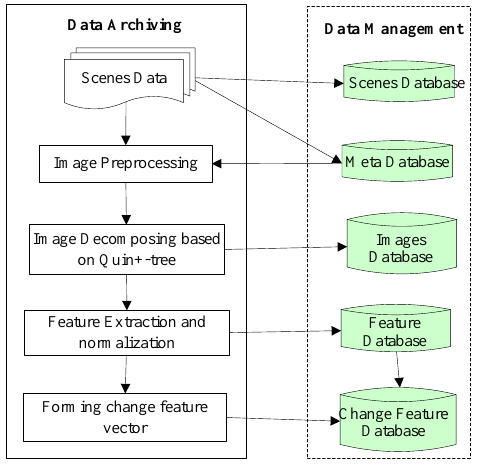
Figure 3. Flow chart for the remote sensing image preprocessing and data